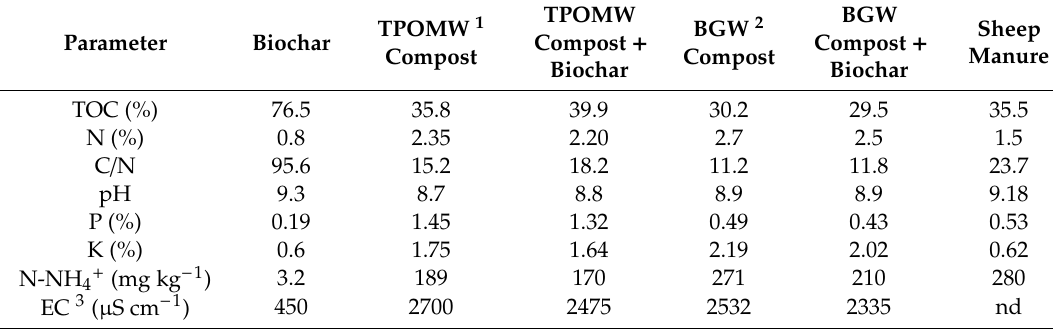
Table 2. Physicochemical properties of the biochar and organic amendments (compost, biochar-blended composts and manure) used in the field